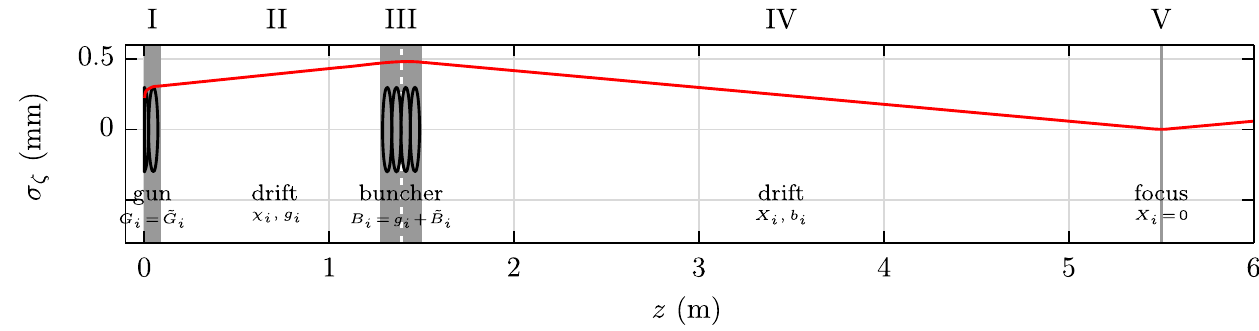
FIG. 2. Schematic of the cavity positions at R EGAE and the drift spaces up to the longitudinal focus; an exemplary bunch length evolution is indicated by the red line. The electron gun is at (I), followed by a first drift section, (II), until the buncher cavity is reached at (III); the dashed, white line indicates the thin lens approximation of the buncher cavity. The second drift is marked by (IV) and delimited by the longitudinal focus, (V). The shaded zones will be kept for all drift plots throughout this article for illustration purposes. The ~ ~ B G parameters , G , g , , B and b will be used in the course of the article to describe the energy of the bunch as a polynomial in the i i i i i i respective zones, while χ and X are the polynomial coefficients for the description of the spatial shift of particles in the longitudinal i i phase space of the